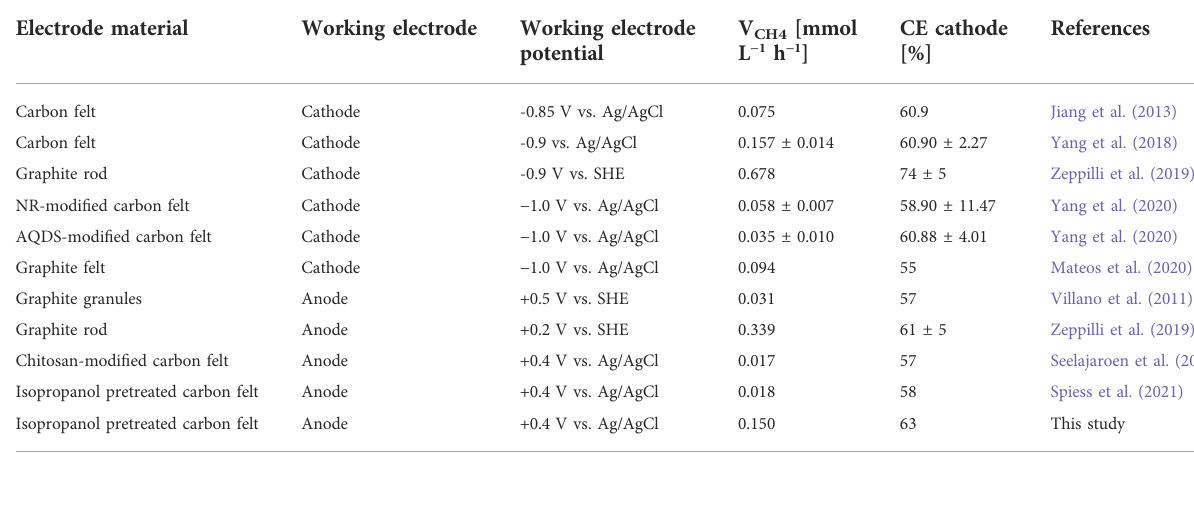
TABLE 2 Comparison of two-chamber CH 4 producing MECs.